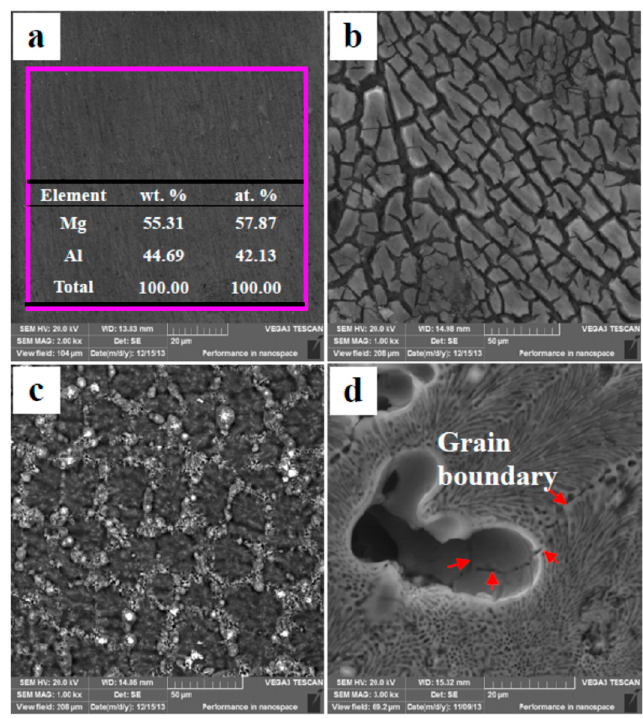
Figure 10. Surface morphologies of the SP Mg 17 Al 12 and the Mg–Al alloy: ( a ) Original morphology of the SP Mg 17 Al 12 (un-etched); ( b ) the SP Mg 17 Al 12 alloy’s corrosion morphology after 90 min of immersion in H 2 SO 4 solution; ( c ) the SP Mg 17 Al 12 alloy’s corrosion morphology after 90 min of immersion in HAc solution; ( d ) the Mg–Al alloy’s corrosion morphology after 30 min of immersion in HAc solution.